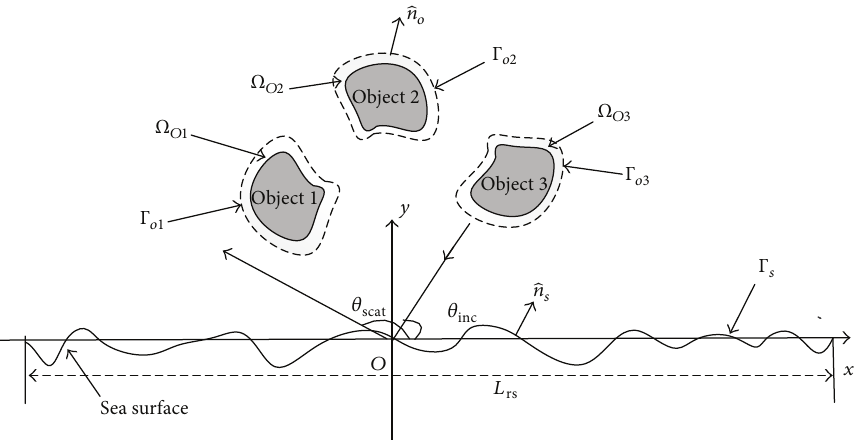
Figure 1: Geometry of scattering from multiple objects above rough sea